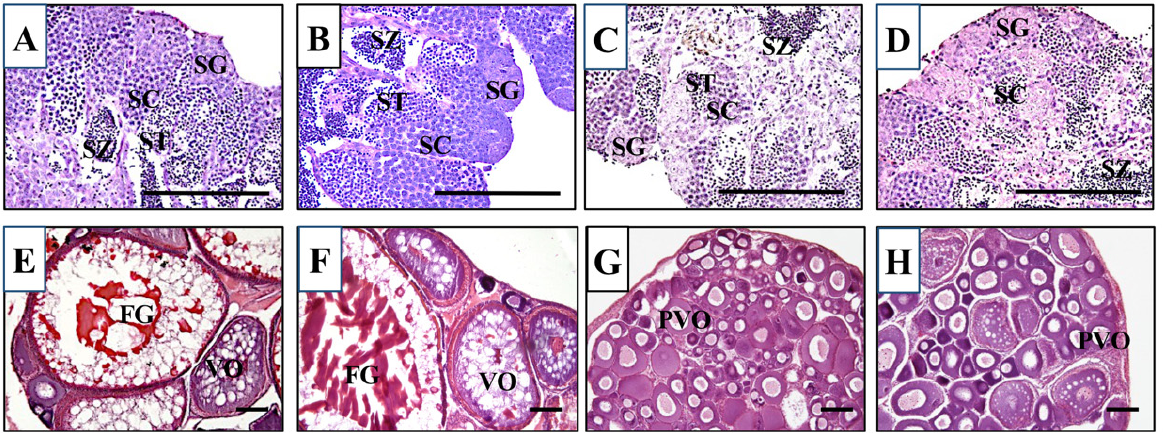
Figure 2. Histological sections of double-hetero ( A ), lhr -KO ( B ), fshr -KO ( C ), and double-KO ( D ) male medaka testes and double-hetero ( E ), lhr -KO ( F ), fshr -KO ( G ), and double-KO ( H ) female medaka ovaries. FG: full-grown oocyte, PVO: pre-vitellogenic oocyte, SC: spermatocyte, SG: spermatogonium, ST: spermatid, SZ: spermatozoa, VO: vitellogenic oocyte. Bar, 100 µ m.